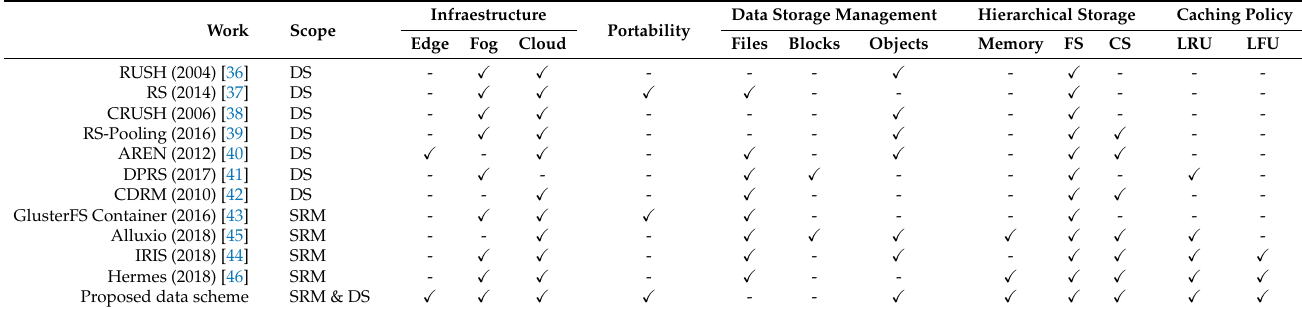
Table 1. Summary of storage tools for the data management and distribution